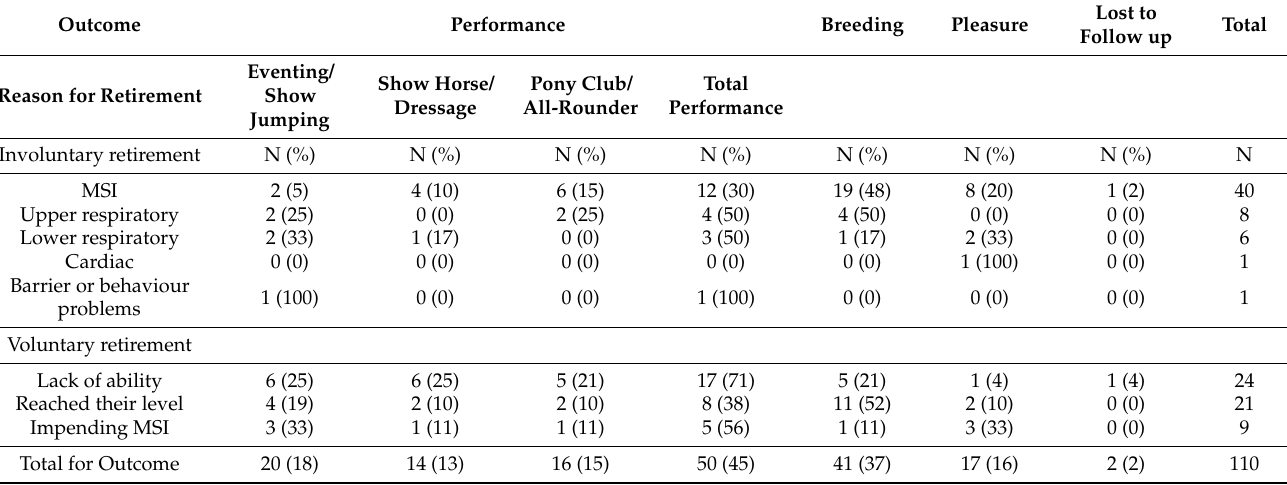
Table 7. Voluntary and involuntary retirement by the medium-term outcomes for 110 thoroughbred horses after retirement from